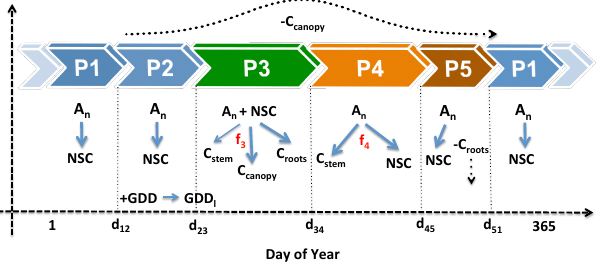
Figure 1. Outline of the different phenological phases (P1 to P5) and carbon allocation in the model within a given year. A n : net daily carbon assimilation; NSC: storage (non-structural carbohydrates); GDD: growing degree days; GDD l = parameter determining shift from P2 to P3 (see text); C: carbon allocated either to the stem, canopy or roots; d : day of year. Solid arrows correspond to alloca- tion within the plant, whereas dashed arrows correspond to litterfall (canopy or roots). f 3 and f 4 are nonlinear functions of soil water content and temperature, determining carbon allocation to different compartments (see text for more